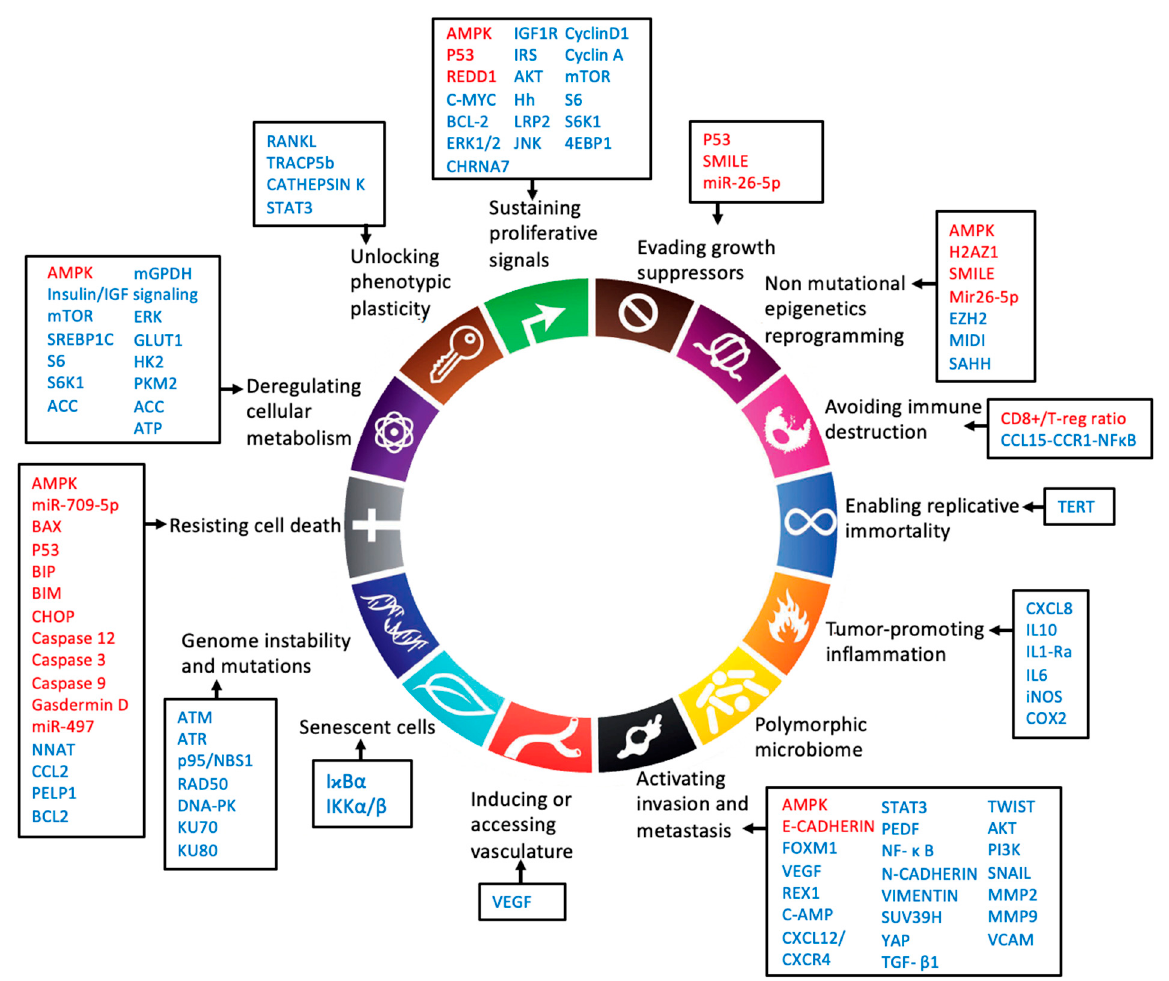
Figure 2. Metformin and hallmarks of cancer, genes regulated directly or indirectly by metformin in thyroid prostate and head and neck cancer. Red genes: activated; blue genes: inhibited (9 modified). Acetyl-CoA carboxylase (ACC), AKT Serine/Threonine Kinase (AKT), AMPK (adenosine monophosphate-activated protein kinase), Ataxia Telangiectasia Mutated (ATM), Adenosine triphosphate (ATP), Ataxia Telangiectasia And Rad3-Related Protein (ATR), Na+/I- symporter (NIS), BCL2 Associated X, Apoptosis Regulator (BAX), Bcl-2 Interacting Mediator Of Cell Death (BIM), B-Cell CLL/Lymphoma 2 (BCL2), Binding-Immunoglobulin Protein (BIP), Cholinergic Receptor Nicotinic Alpha 7 Subunit (CHRNA7), C/EBP Homologous Protein (CHOP), cyclic AMP (cAMP), C-C Motif Chemokine Ligand 2 (CCL2), C-C Motif Chemokine Receptor 1 (CCR1), C-X-C Motif Chemokine Ligand 8 (CXCL8), C-X-C Motif Chemokine Ligand 12 (CXCL12), C-C Motif Chemokine Ligand 15 (CC15), C-X-C motif chemokine receptor 4 (CXCR4), Cyclooxygenase 2 (COX2), DNA-dependent protein kinase (DNA-PK), Eukaryotic Translation Initiation Factor 4E Binding Protein 1 (4EBP1), Extracellular Signal-Regulated Kinase 2 (ERK), Enhancer Of Zeste 2 Polycomb Repressive Complex 2 Subunit (EZH2), Forkhead Box M1 (FOXM1), Glucose transporter 1 (Glut1), H2A.Z variant histone 1 (H2AZ1), Hexokinase-2 (HK2), Hedgehog (Hh), NF κ B Inhibitor Alpha (I κ B ακ ), Inhibitor of nuclear factor kappa-B kinase subunit alpha/beta (I κκα / β ), Interleukin-6 (IL6), Interleukin-10 (IL-10), Interleukin-1 receptor alpha (IL1-Ra), Inducible nitric oxide synthase (iNOS), Interleukin-6 receptor (IL6R), Insulin Like Growth Factor 1 Receptor (IGF1R), Insulin Receptor Substrate (IRS), JUN N-Terminal Kinase (JNK), LDL Receptor Related Protein 2 (LRP2), X-Ray Repair Cross Comple- menting 6 (Ku70), X-Ray Repair Cross Complementing 5 (Ku80), Mammalian target of rapamycin (mTOR), MAPK/ERK Kinase 1 (MEK), Midline-1 (MID1), Mitochondrial GAPDH (mGPDH), Ma- trix Metallopeptidase 2 (MMP2), Matrix Metallopeptidase (MMP9), MYC Nuclear Factor Kappa B (NF κ B), Tumor Protein P53 (P53), Pigment epithelium-derived factor